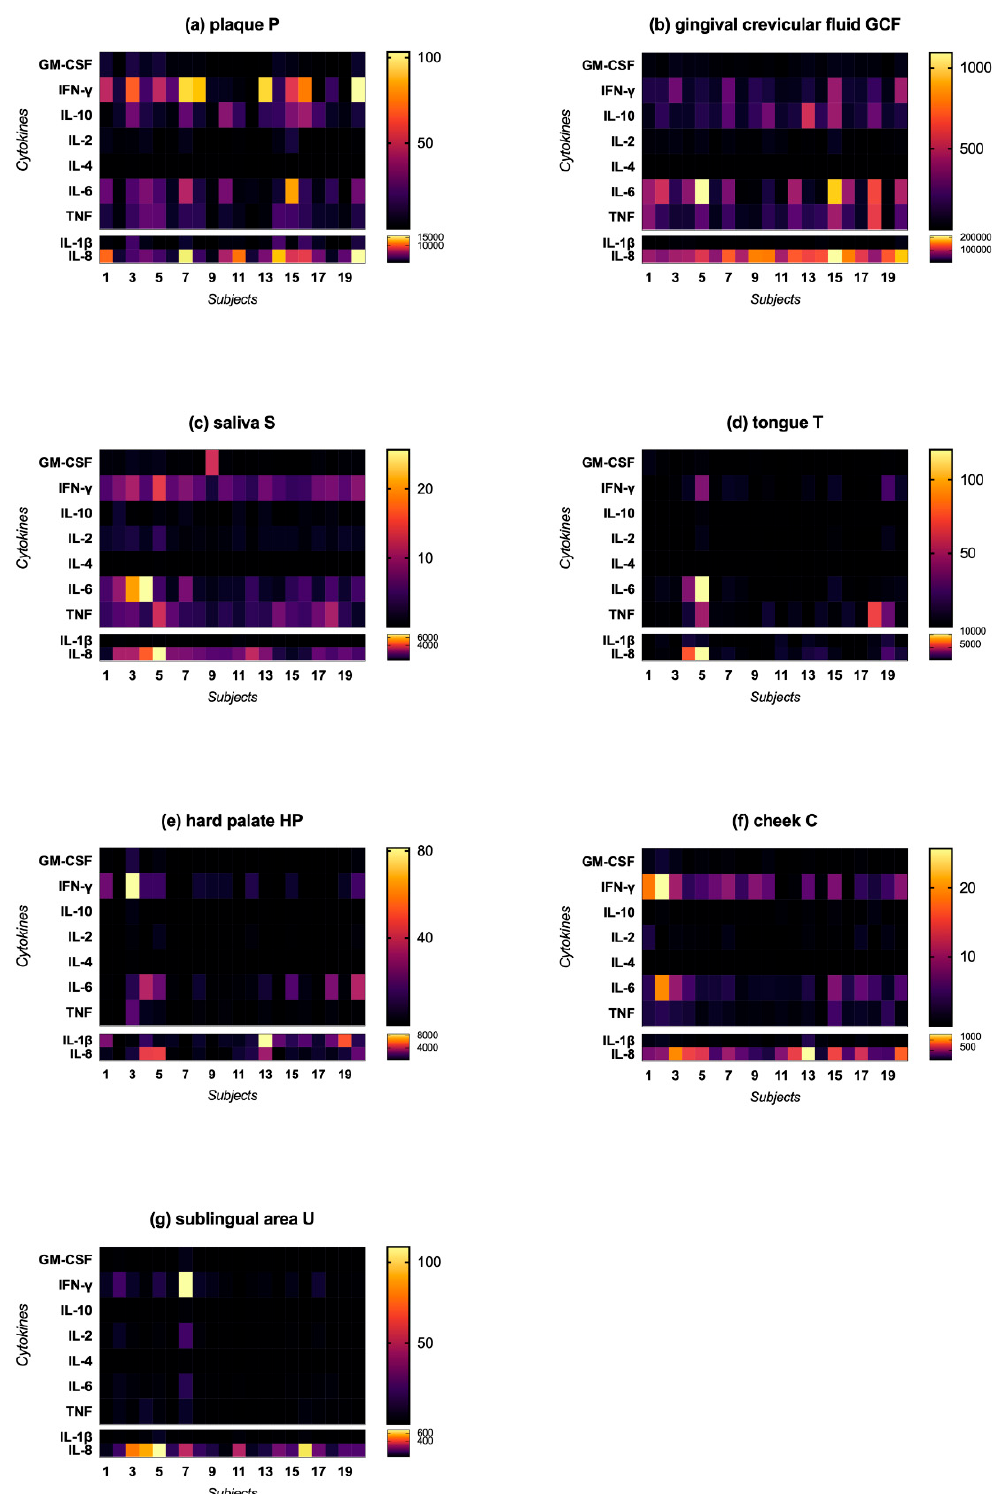
Figure 4. Heat map visualization of the cytokine concentration in different analyzed oral cavity sites including ( a ) supragingival plaque P, ( b ) gingival crevicular fluid GCF, ( c ) saliva S, ( d ) tongue T, ( e ) hard palate HP, ( f ) cheek C and ( g ) sublingual area U with the expression pattern of the pro- and anti-inflammatory cytokines. The cytokine concentration of GM-CSF, IFN- γ , IL-10, IL-2, IL-4, IL-6, TNF, IL-8 and IL-1 β is shown. The inferno colour scale indicates the abundance of each cytokine in each subject, from black (zero, not observed) to very light yellow (highly abundant).